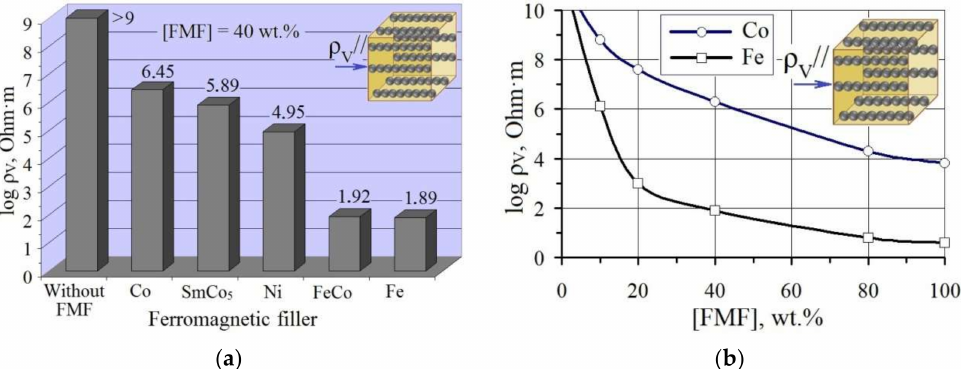
Figure 14. The effect of nature ( a ) and content ( b ) of FMF on volumetric electrical resistivity ( ρ V ) of FMF/HEMA-gr-PVP composites obtained in a magnetic field (HEMA:PVP = 70:30 mass parts, H = 23